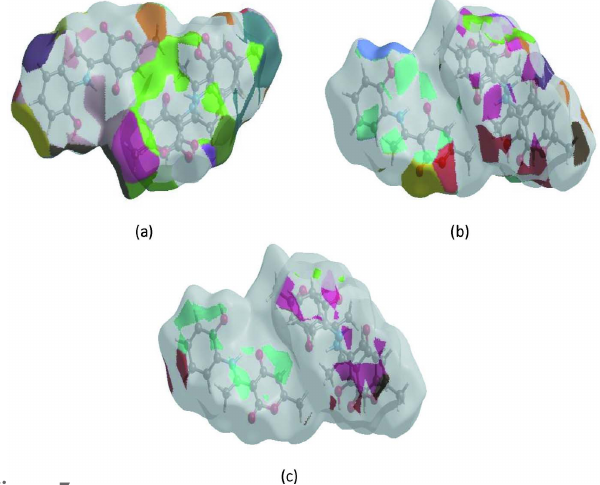
Figure 7 The Hirshfeld surface representations with the function d norm plotted onto the surface for ( a ) H (cid:2)(cid:2)(cid:2) H, ( b ) H (cid:2)(cid:2)(cid:2) O/O (cid:2)(cid:2)(cid:2) H and ( c ) H (cid:2)(cid:2)(cid:2) C/C (cid:2)(cid:2)(cid:2) H interactions.